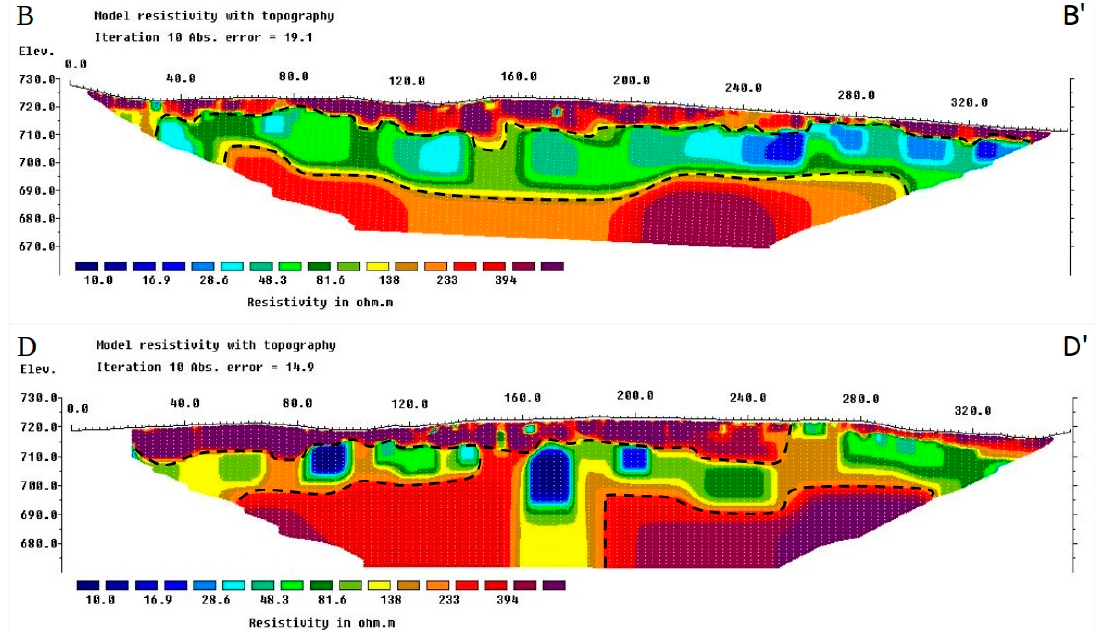
Figure 8. Electrical resistivity results collected using a dipole-dipole along B - B’ and D - D’ lines with 5 m electrode spacing covering a distance of 355 m and a depth of 59 m. The black dotted lines show the thickness of claystone (perched aquifer).